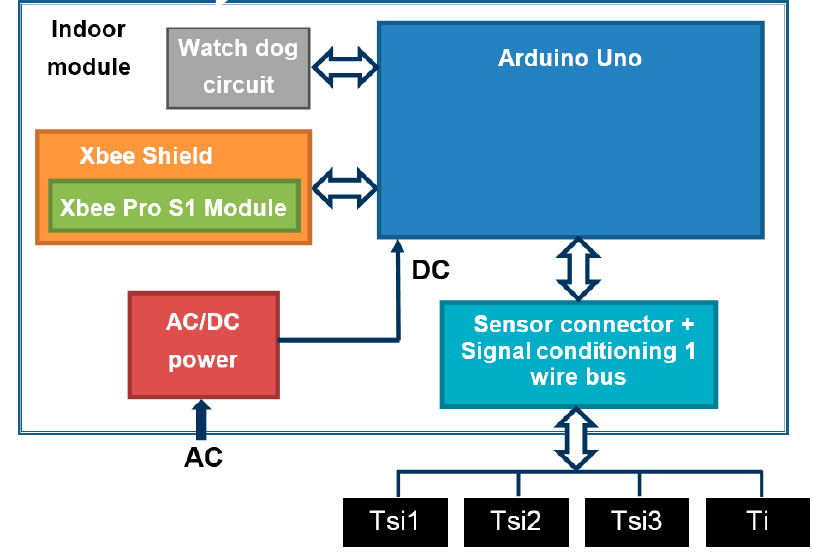
Figure 5. Indoor module block diagram.